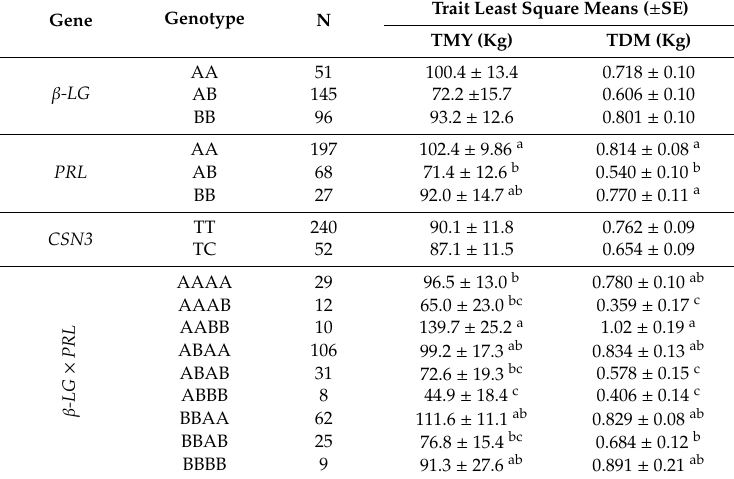
Table 5. E ff ect of Beta lactoglobuline ( β -LG) , Prlactin ( PRL) , and Kappa casein (CSN3) genotypes and significant interaction e ff ects on milk production traits in Awassi